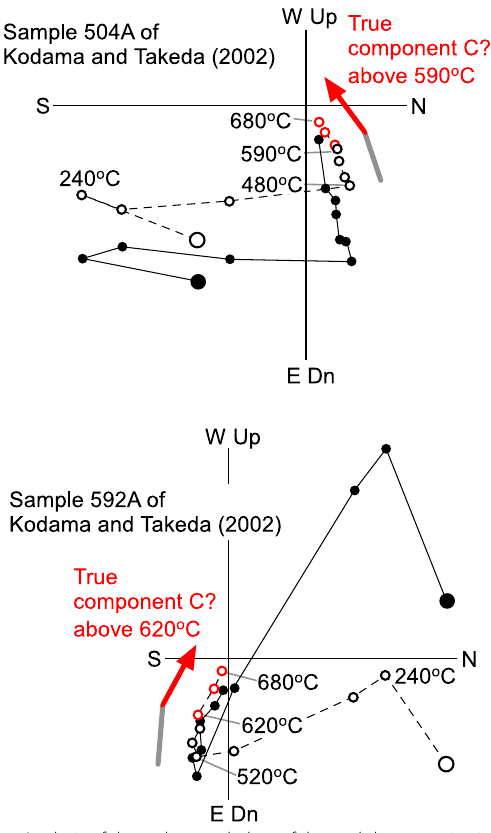
Fig. 8 APWP for southwest Japan from the Early Cretaceous to Miocene (with an associated 95% confidence limit). Pole data after Uno et al. (2021) except for 100